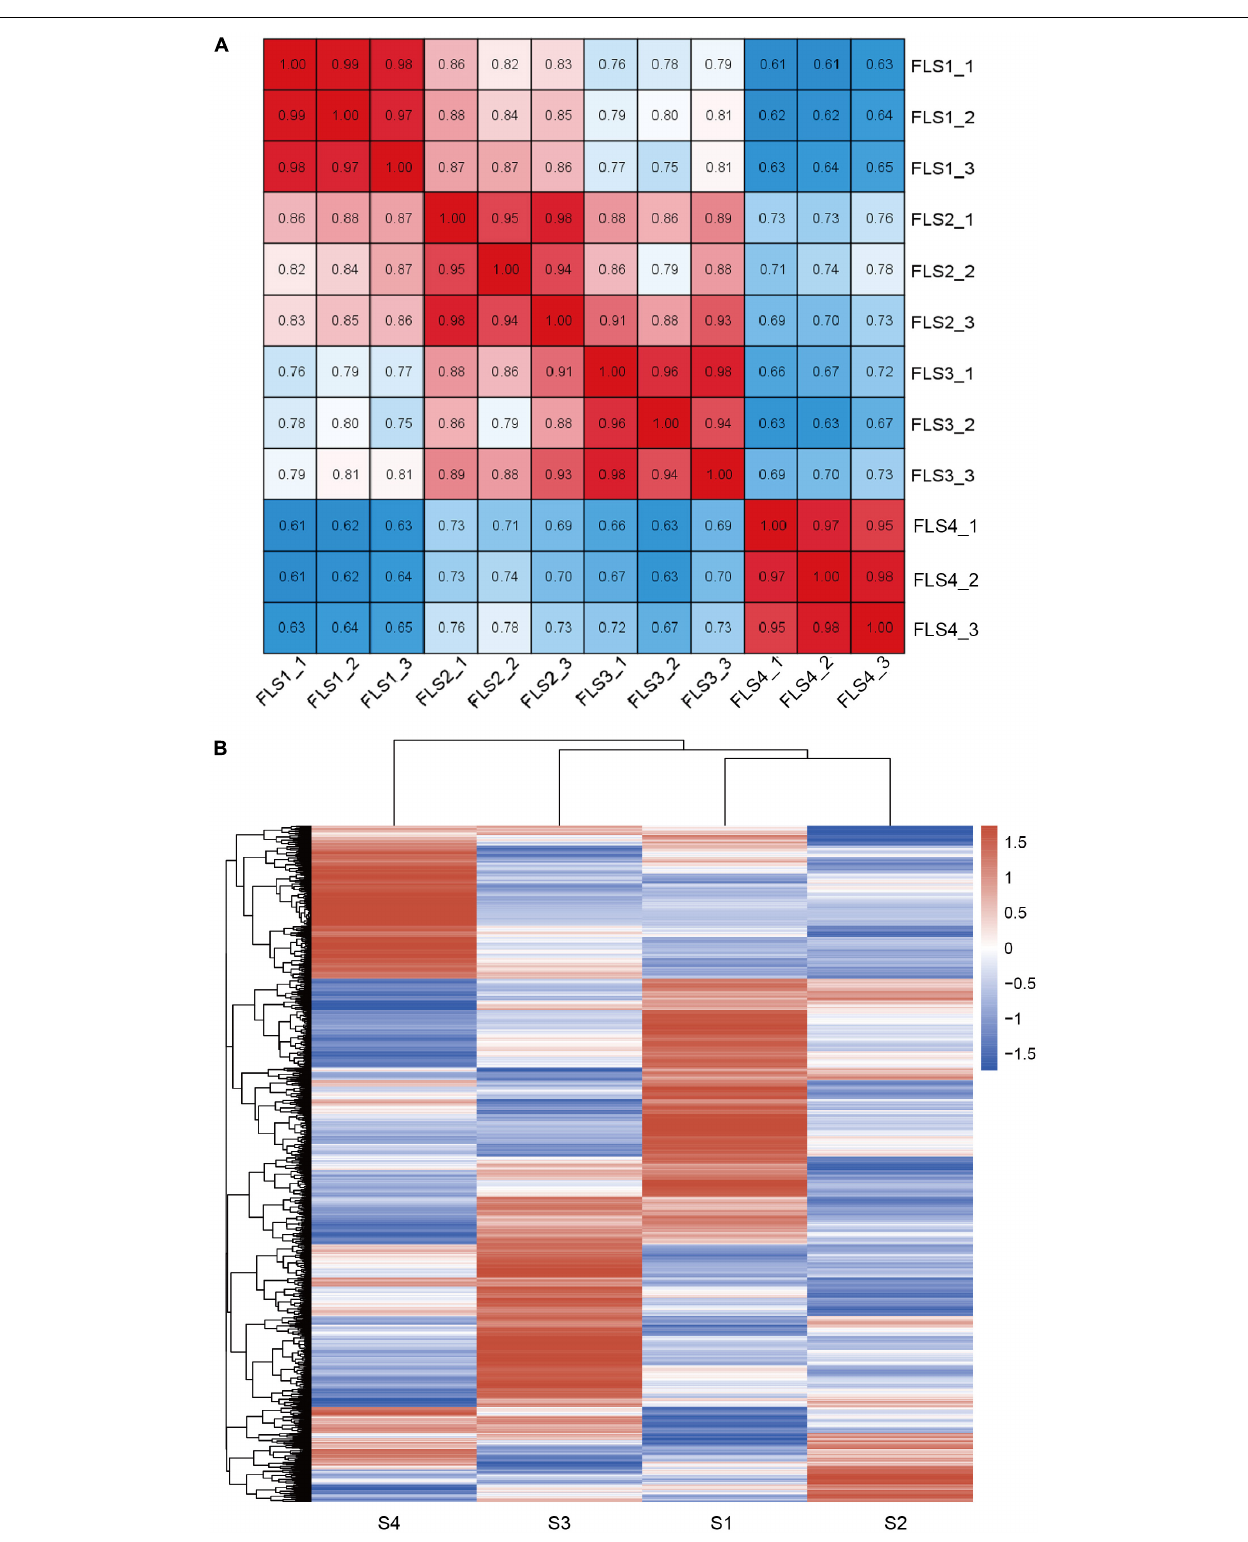
Frontiers in Plant Science |